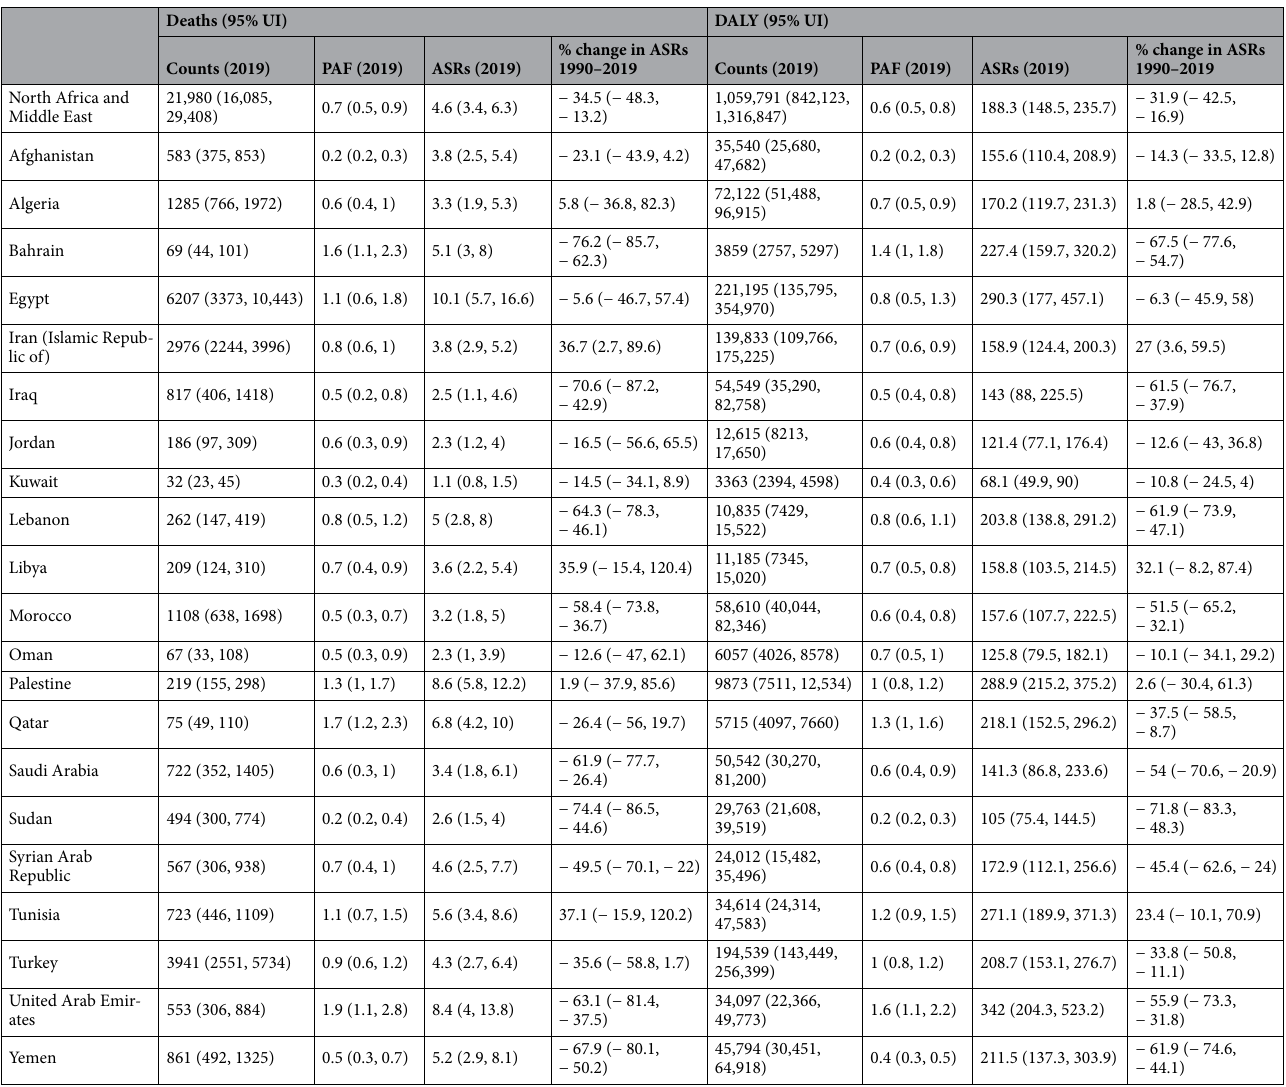
Table 1. The burden of diseases attributable to alcohol consumption in the Middle East and North Africa region in 2019 and percentage change of age-standardised rates during 1990–2019 (Generated from data available from http:// ghdx. healt hdata. org/ gbd- resul ts- tool). DALY Disability adjusted life year, GBD Global Burden of Disease, ASRs Age-standardised